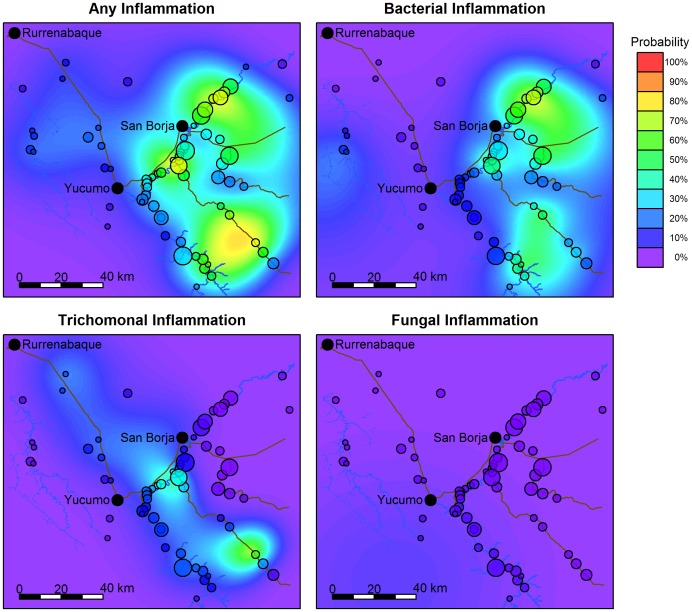
Geographical distribution of GM from PAP tests.Circles represent location of study villages, and circle size indicates relative sample size. Estimates are derived from generalized additive models controlling for age and weighted to adjust for sample bias (see text). Regions between villages are simulated by the model. Refer to Supplementary Material for geographical distribution of gynecological exams (figure S4), and geographical distribution of GM without sample weights (figure S5).